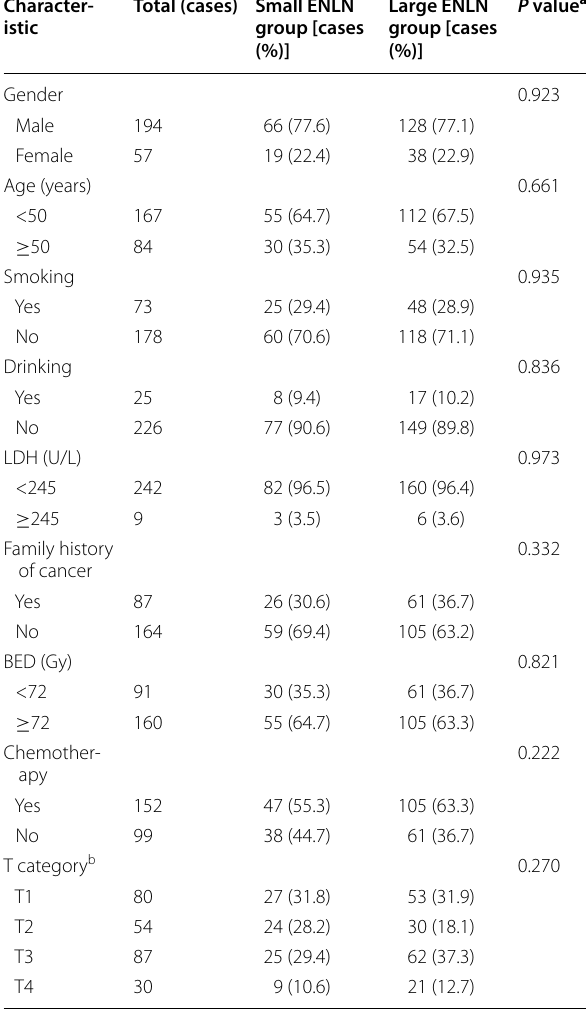
Table 1 Baseline characteristics of the 251 patients with N0-category nasopharyngeal carcinoma (NPC) and enlarged neck lymph nodes